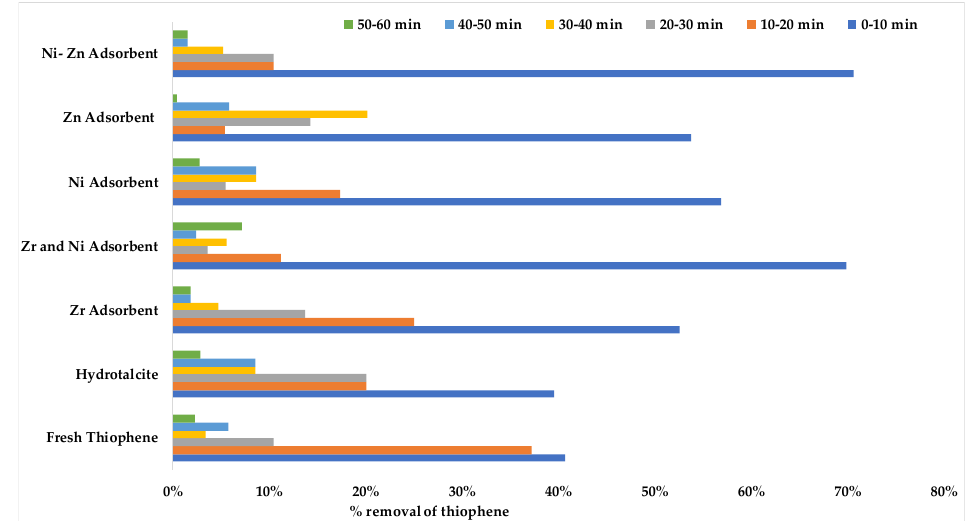
Figure 8. Percent removal of thiophene with respect to different time interval.